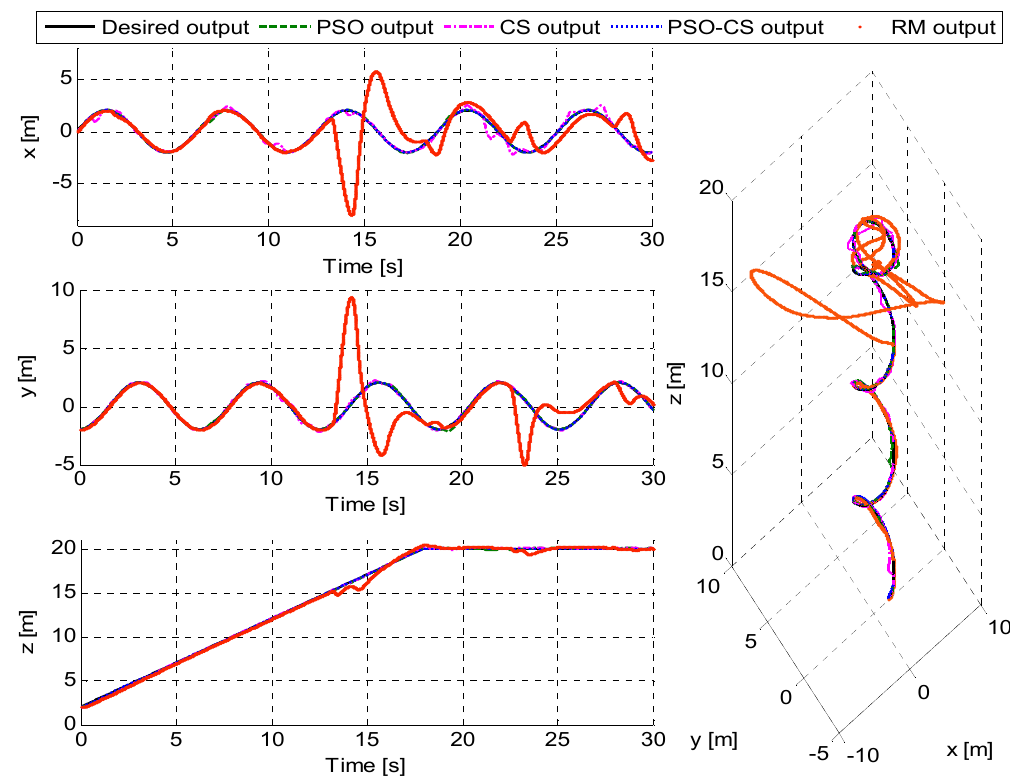
Figure 18. Quadrotor’s positions ( x , y , z ) Particle Swarm Optimization (PSO), Cuckoo Search (CS), Particle Swarm Optimization-Cuckoo Search (PSO-CS), and Reference Model (RM) with disturbance (helical trajectory).